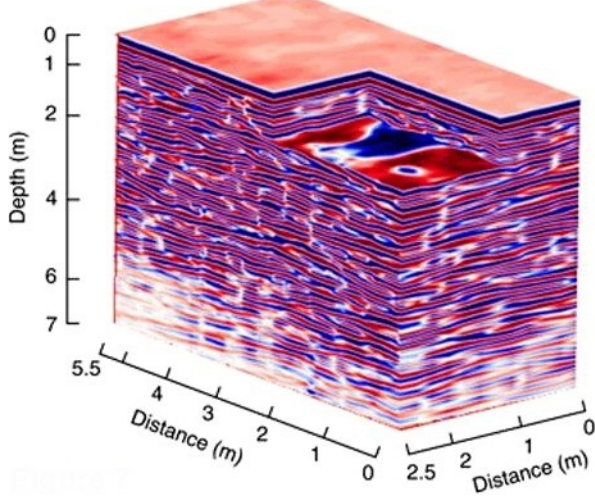
Fig. 6. GPR chair diagram of a 3-D cube collected in the tea room of the Cactus House. Where enough floor space was available parallel 2-D lines were collected to better understand the subsurface through 3-D perspectives (after Jol et al.,